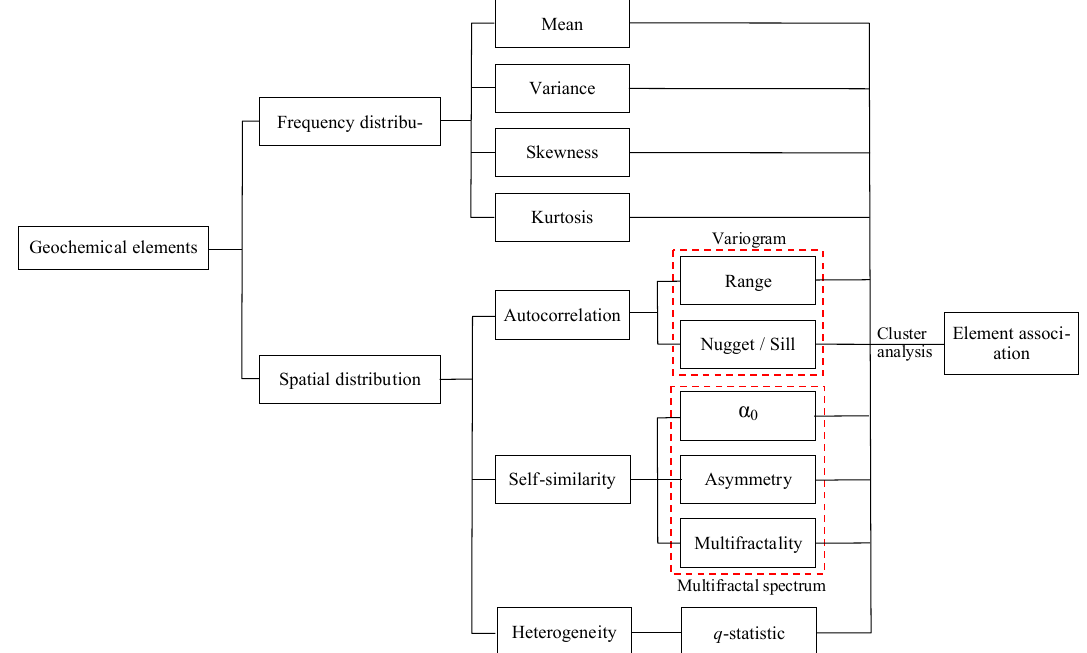
Figure 1. The workflow to explore distribution characteristics and association of geochemical elements.